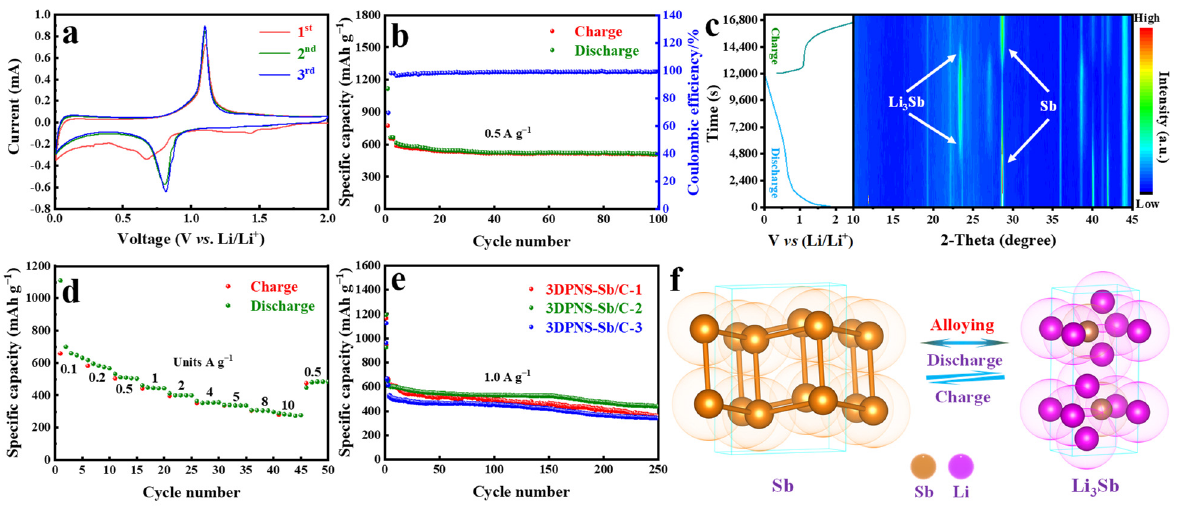
Figure 4. ( a ) CV curves of 3DPNS-Sb/C-2 electrodes at a scan rate of 0.1 mV s − 1 , ( b ) Cycle perfor- mance of 3DPNS-Sb/C-2 electrodes at 0.5 A g − 1 for 100 cycles, ( c ) In-situ XRD of 3DPNS-Sb/C-2 elec- trodes, ( d ) Rate capability of 3DPNS-Sb/C-2 electrodes at current densities from 0.1 to 10 A g − 1 , ( e ) Cycle performance of 3DPNS-Sb/C-1, 3DPNS-Sb/C-2 and 3DPNS-Sb/C-3 electrodes at 1 A g − 1 for 250 cycles, ( f ) The crystal structures of the active Sb in 3DPNS-Sb/C in the charge/discharge course. Table 1. Contrast of the electrochemical properties of 3DPNS-Sb/C composites (this work) and var- ious reported Sb-C as anodes for LIBs. Ref.